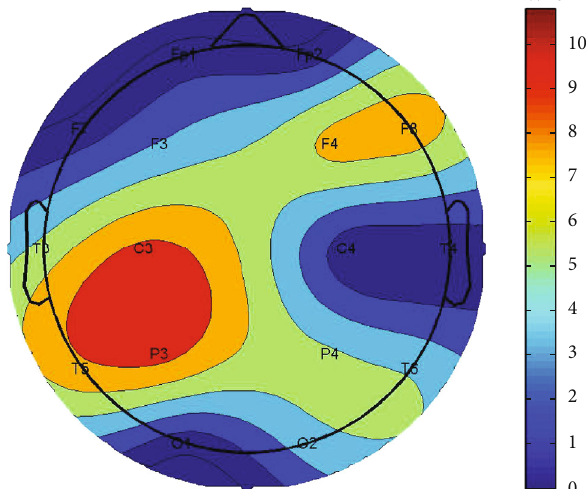
Figure 2: The topographic map of fuzzy entropy di ff erence before and after seizure in the delta band. The red areas indicate that the di ff erences are more signi fi cant.